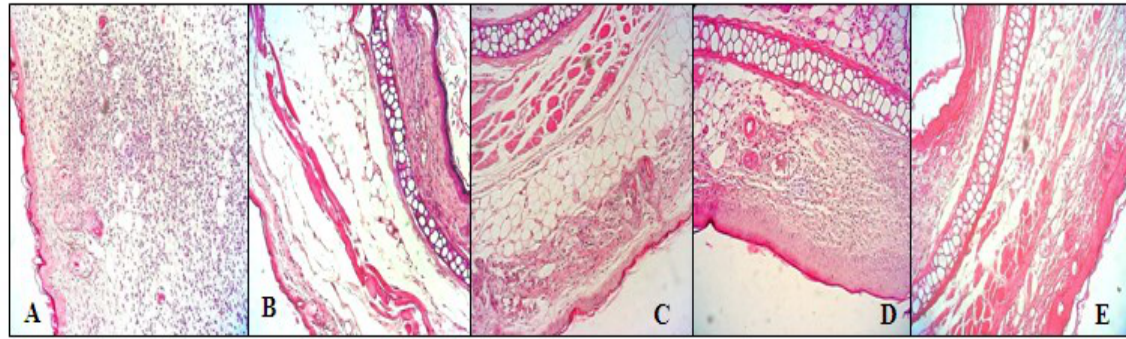
Figure 6. Histological analysis of ear edema with H & E stain 200× from animals submitted to the croton oil-induced ear edema test and treated with P. dermoporus polysaccharides: ( A ) positive control (croton oil); ( B ) negative control (saline); ( C ) P. dermoporus polysaccharides at 10 mg/kg (PD 10); ( D ) animals treated with 30 mg/kg (PD 30); ( E ) animals treated with 50 mg/kg (PD 50)